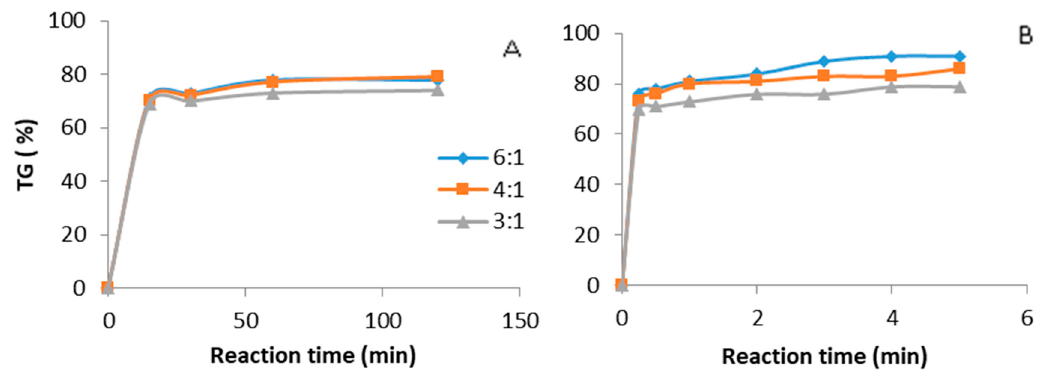
Figure 3. Biodiesel production. Catalyst KOH 0.5 wt %, methanol: oil ratio (6:1, 4:1, 3:1). ( A ) Mechanical stirring batch reactor, temperature 65 °C. ( B ) Ultrasound batch reactor, ultrasound amplitude 60%, temperature 35 °C.